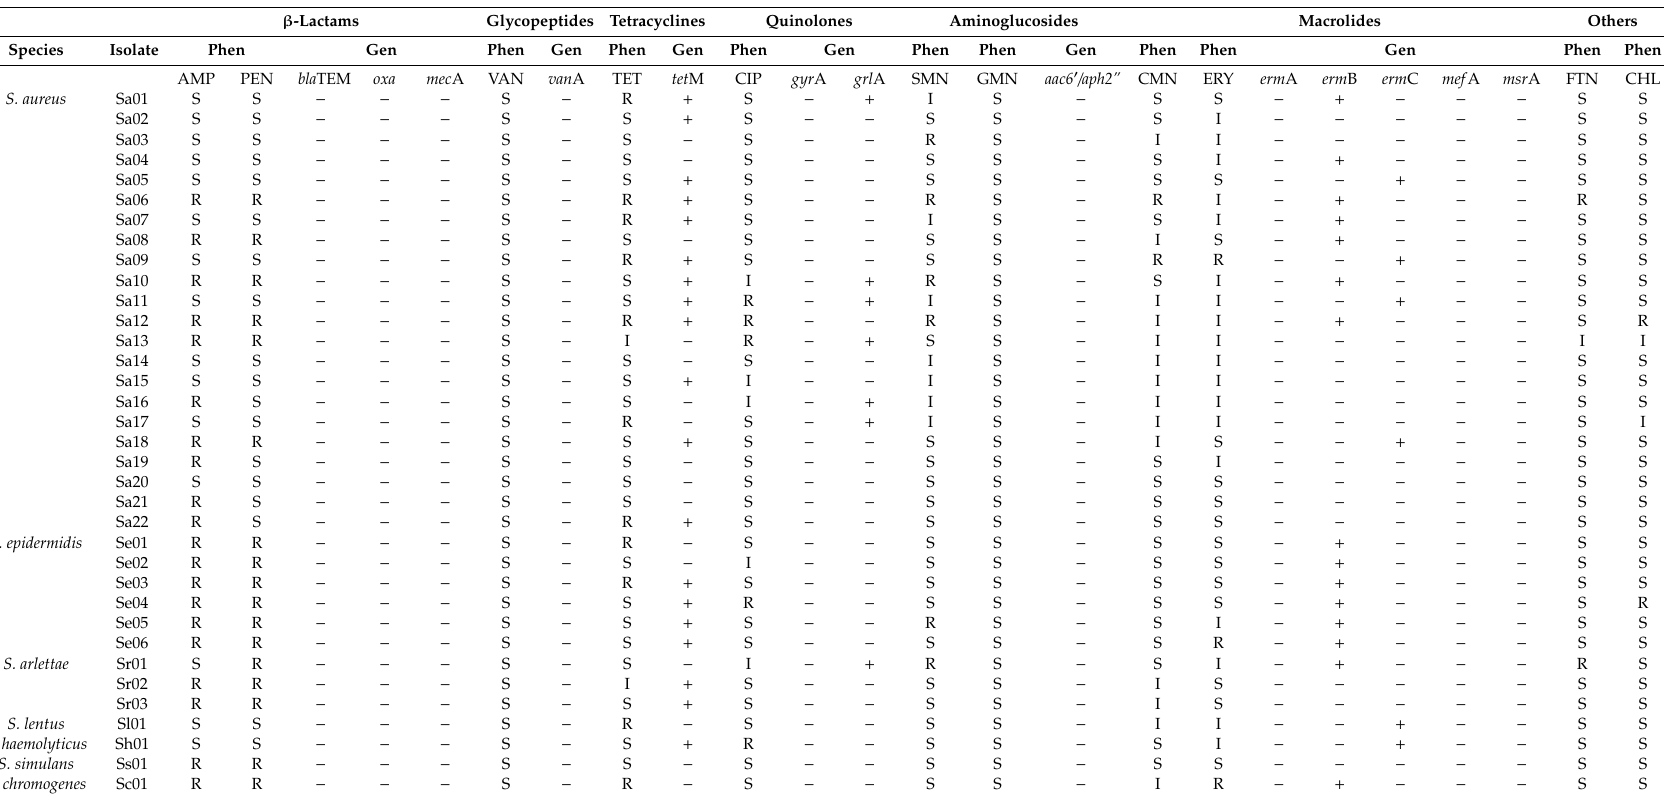
Table 2. Results of phenotypic (Phen) and genotypic (Gen) antibiotic resistance assays. β -Lactams Glycopeptides Tetracyclines Quinolones Aminoglucosides Macrolides Species